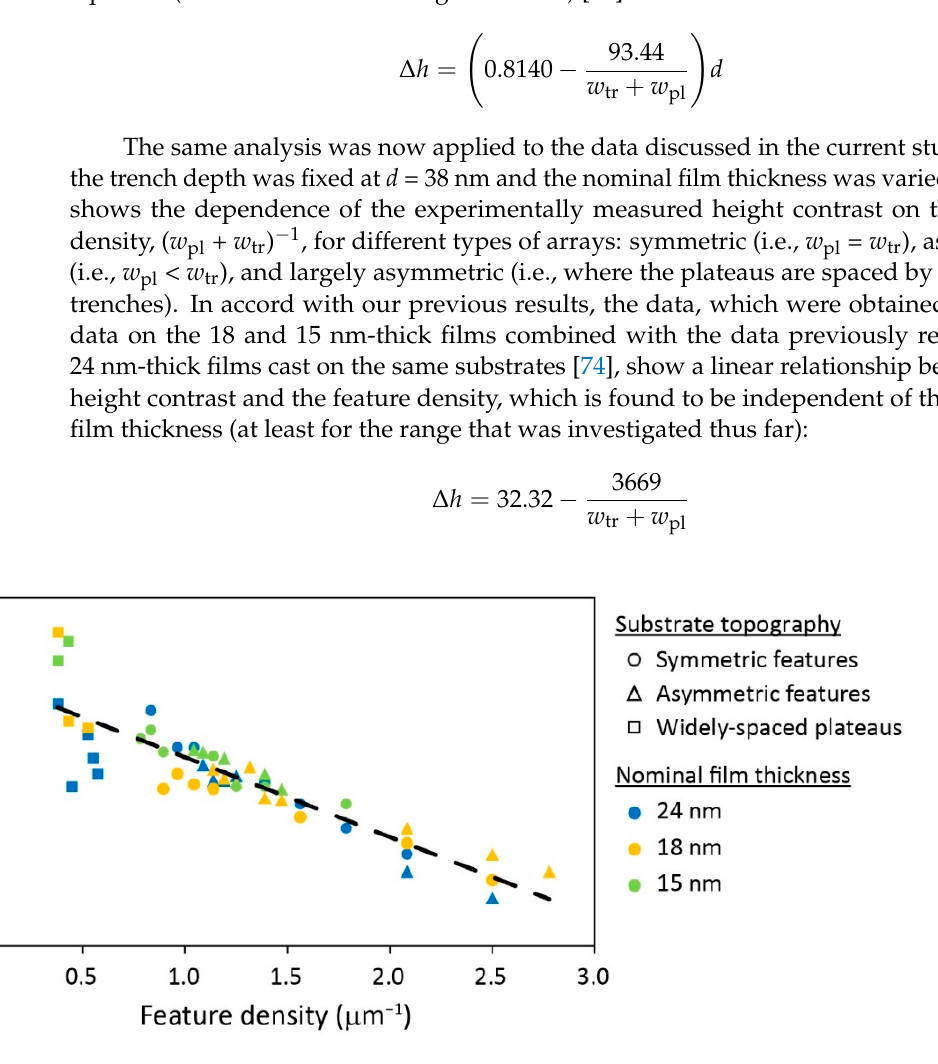
Figure 5. Dependence of height contrast on the topographic feature density for samples with 38 nm trench depth.